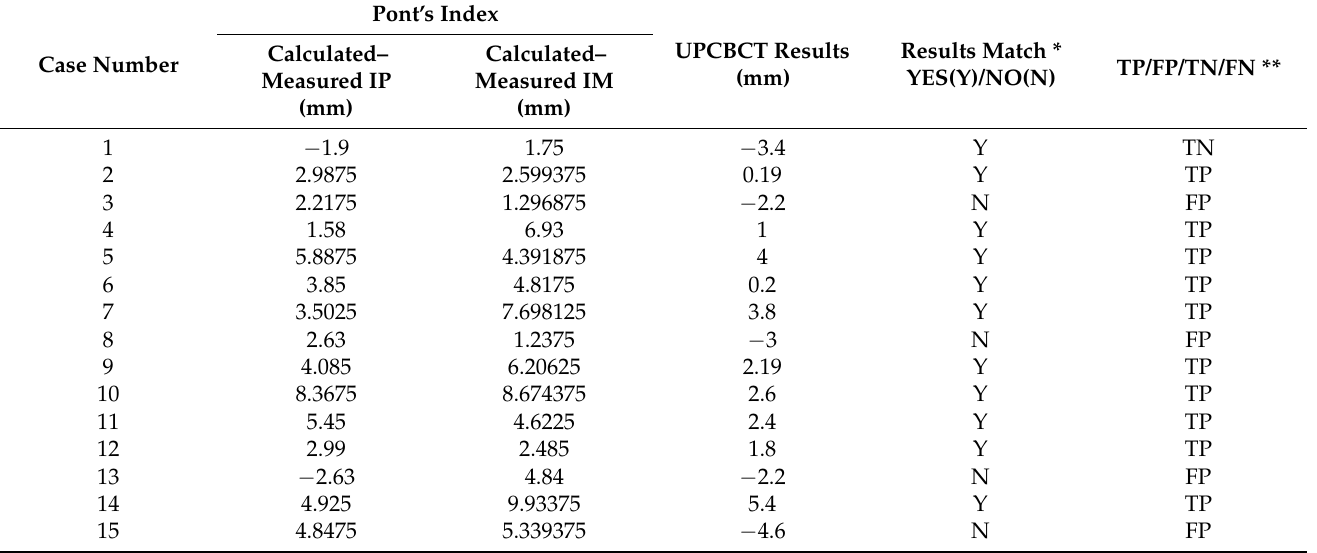
Table 1. Comparative evaluation of a transverse maxillary deficiency using the two methods: PI and UPCBCT